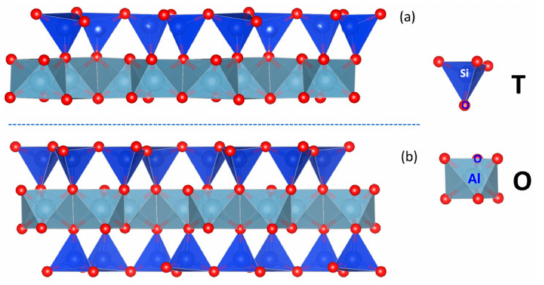
Figure 1. Schematic diagram of clay type ( a ) 1:1 and ( b ) 2:1; O and T represent octahedral and tetrahedral layers,